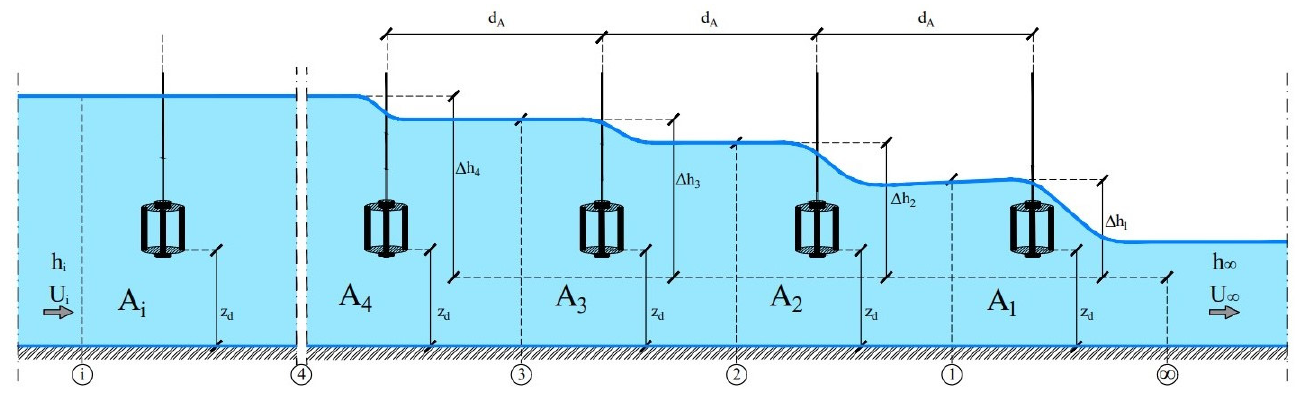
Figure 15. The asymptotic trend of water depth variation Δ h caused by increasing the number of arrays or turbines. Although not appreciable, backwater depth decreases upstream from each hydraulic transition. (Image is not to scale.)